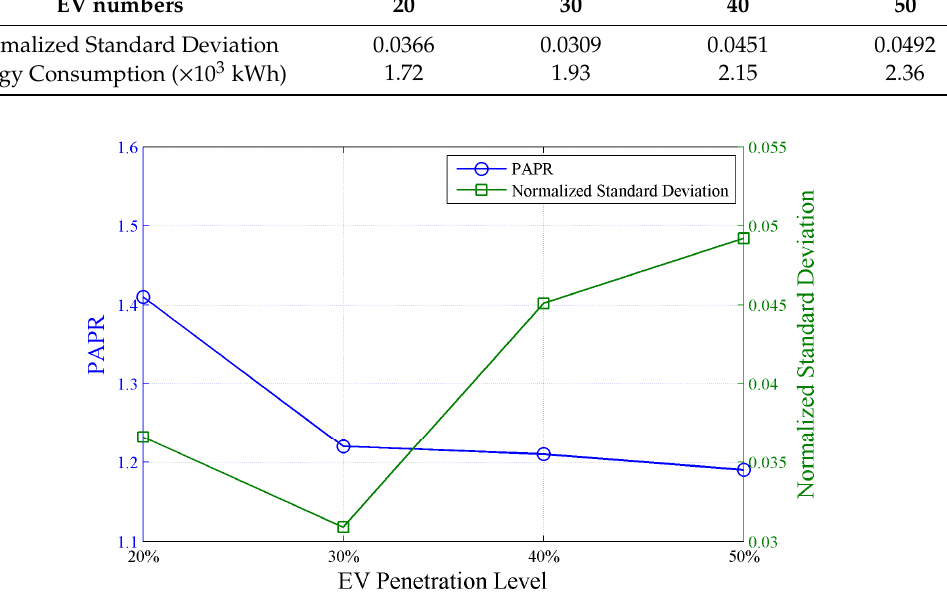
Figure 5. Statistic information of the load profile with EV number of 20, 30, 40, and 50. PAPR: peak-to-average power ratio.